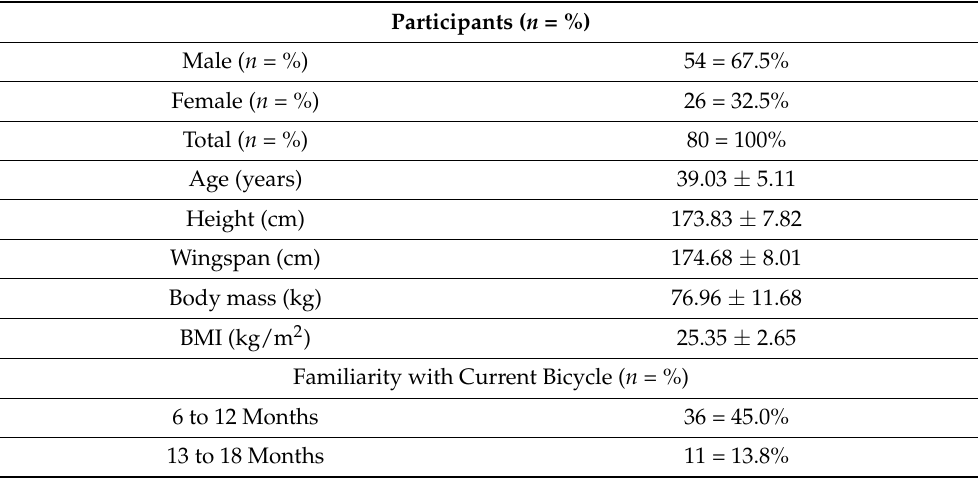
Table 1. Demographicandanthropometriccharacteristicsofallparticipants(Means ±